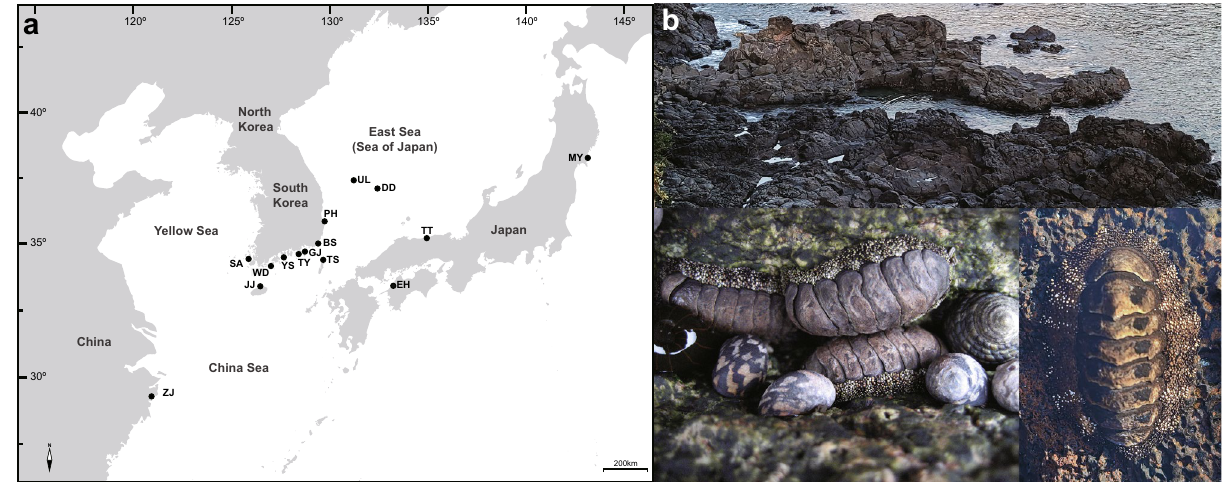
Figure 1. A map showing sampling localities and photos of a habitat landscape and wild samples of Liolophura japonica inhabiting coastal areas of the Korean Peninsula ( N = 249), the Japanese Archipelago ( N = 57), and southern China ( N = 125) in the northwestern Pacific Ocean. (a) A map showing twelve direct sampling localities for L . japonica in coastal areas of the northwestern Pacific Ocean. The sampling localities of one southern Chinese (ZJ) and two Japanese (EH and MY) previously catalogued haplotype sequencing studies retrieved from NCBI are also depicted. Table S1 and S2 contain more accurate information on the populations and individuals. The basic map is from a free map providing site (https://d- maps. com), which is modified with Adobe Illustrator v.25.2. (https:// www. adobe. com). (b) Photos of a habitat landscape and wild samples of L